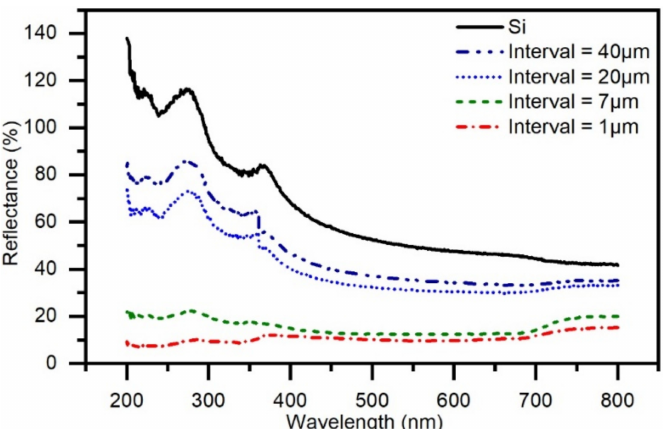
Figure 8. Reflectance spectra of silicon irradiated by a femtosecond laser at different scanning